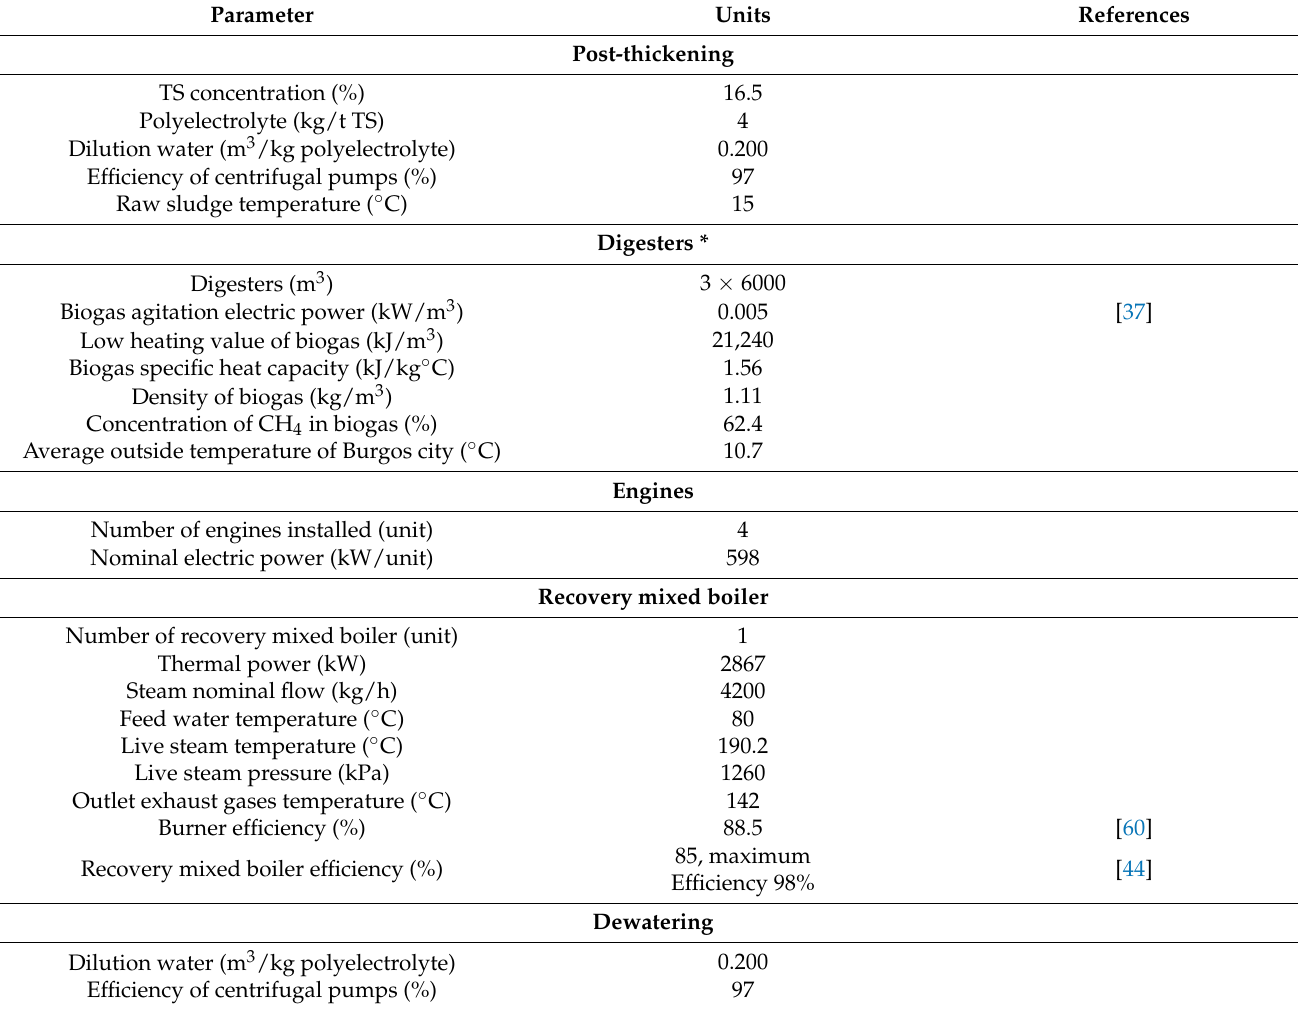
Table A1. Parameters of the WWTP. Technical characteristic of units operating in the different WWTP sections that are common to all scenarios